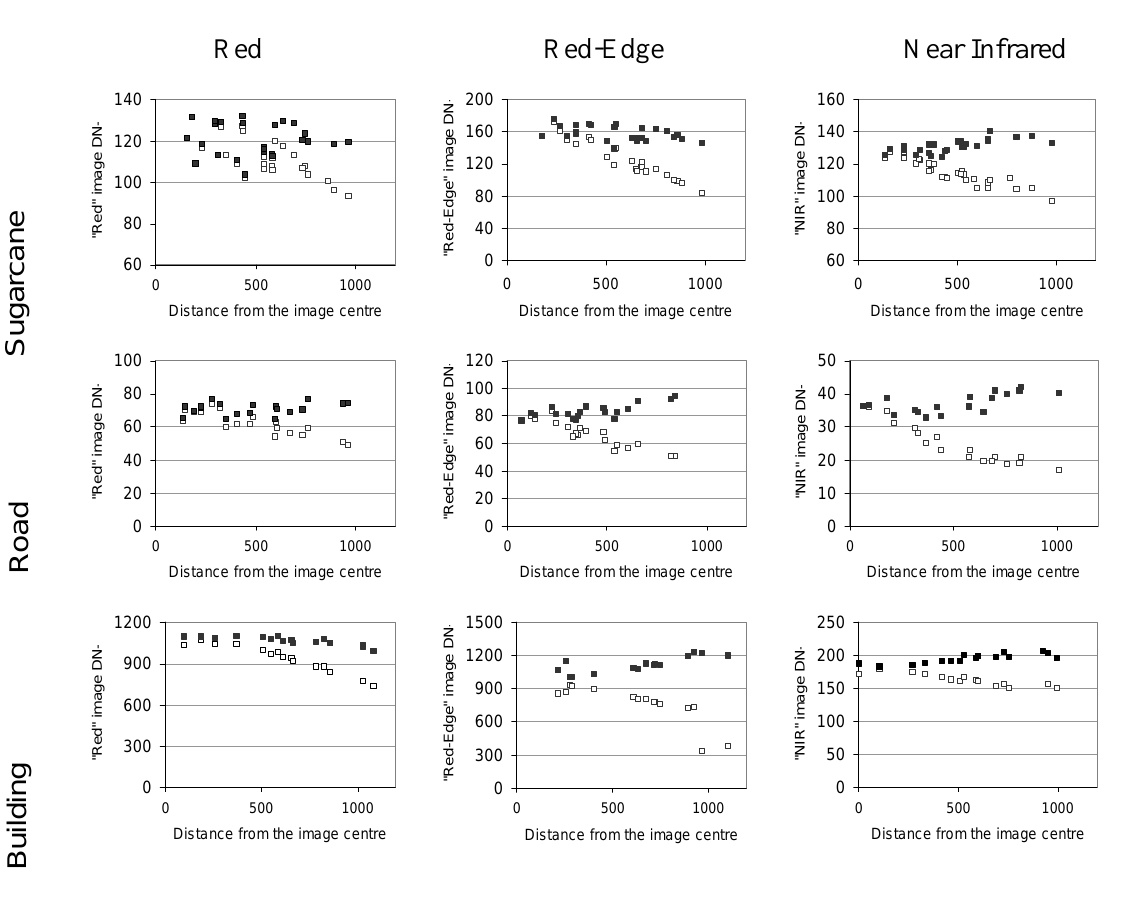
Figure 10. Effect of the vignetting correction on the DN values of three targets (open symbols = before correction; closed symbols = after correction), expressed in distance of the pixel to the centre of the image. The images were acquired on June 29, at different